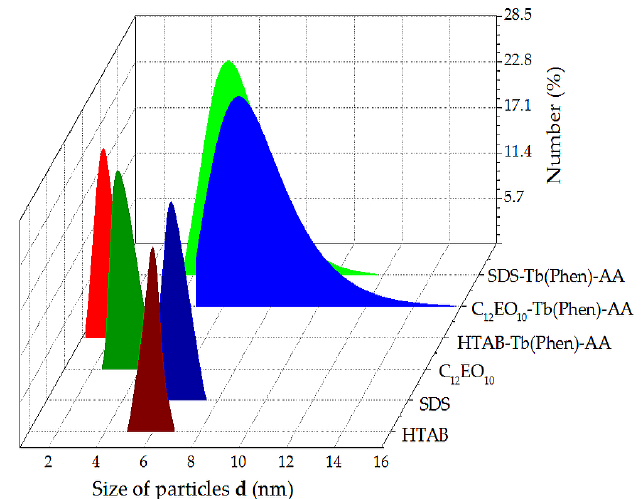
Figure 3. Particle size distribution curves: HTAB ( ); SDS ( ); C 12 EO 10 ( );Tb(Phen)-AA-HTAB ( );Tb(Phen)-AA-SDS ( ); Tb(Phen)-AA-C 12 EO 10 ( ).